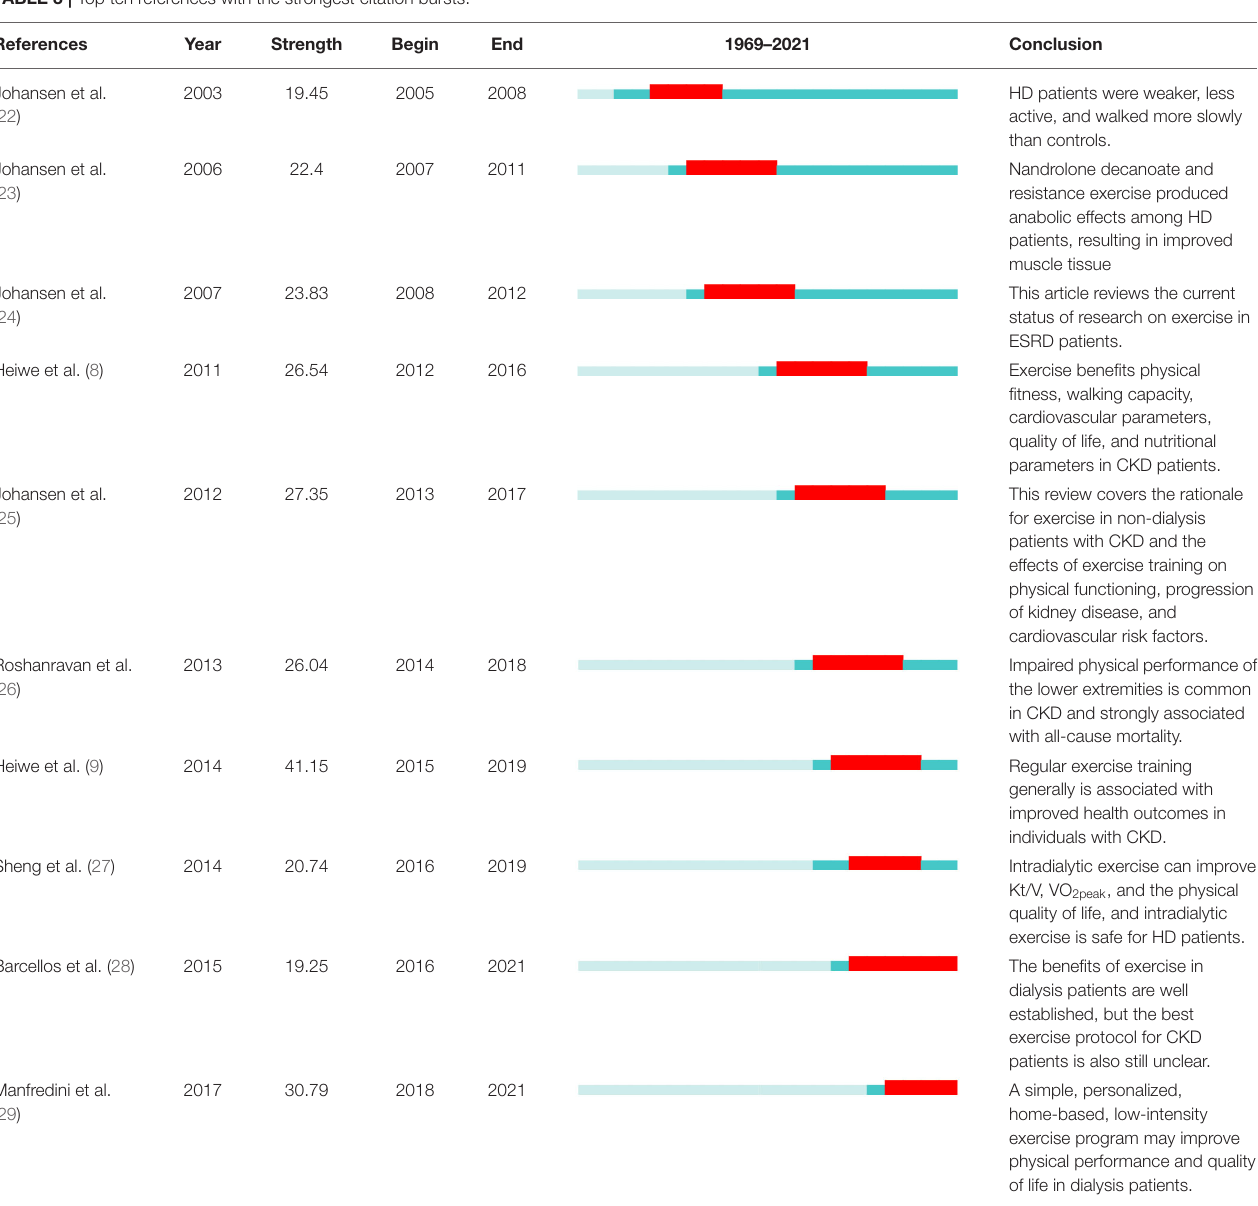
TABLE 3 | Top ten references with the strongest citation